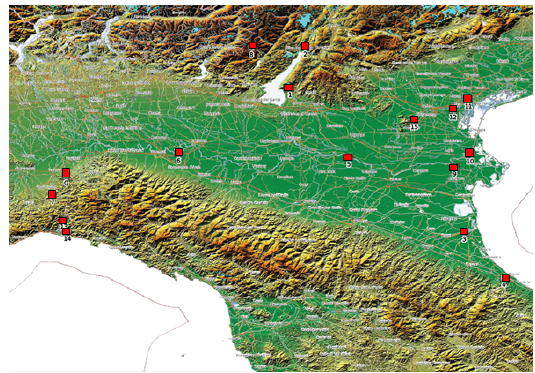
Figure 2: Test areas with 50 cm aerial imagery.